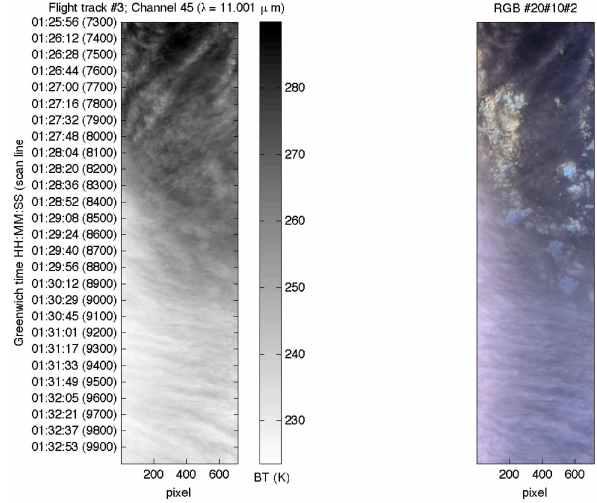
Fig. 8. Cloudy sky scenario. MAS imagery from track 9, 23 Febru- ary 2003 on Pacific Ocean SE from Hawaiian Islands from 01:26 to 01:33UTC. Infrared brightness temperature from channel 45 is presented on left panel. RGB image (right panel) is obtained from channels 20 (2.15µm), 10 (1.64µm), 2